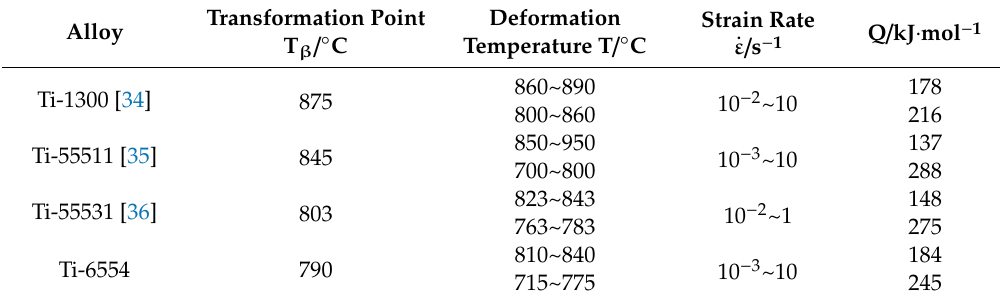
Table 3. Activation energy for several typical high strength-toughness titanium alloys. Transformation Alloy